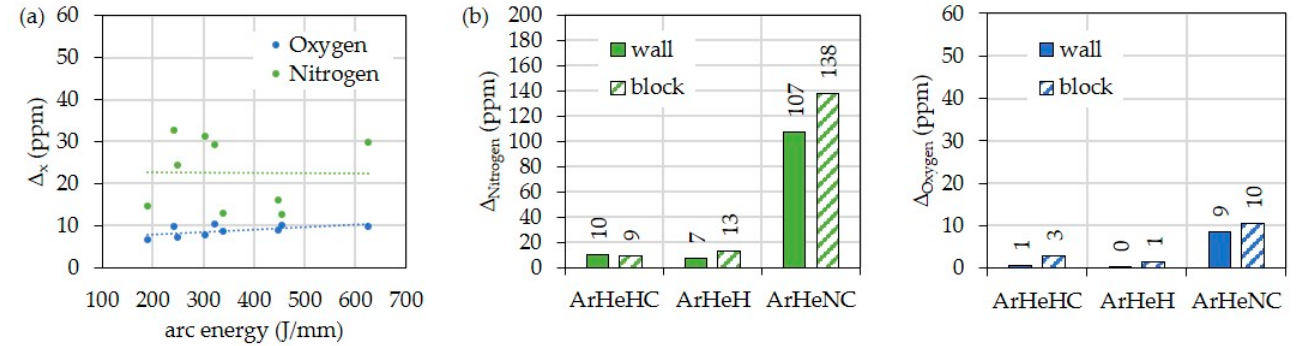
Figure 8. Arithmetic mean values of chemical compositions of HY282 walls and blocks depending on arc energy and shielding gas (scale of y-axis: log to base 2).